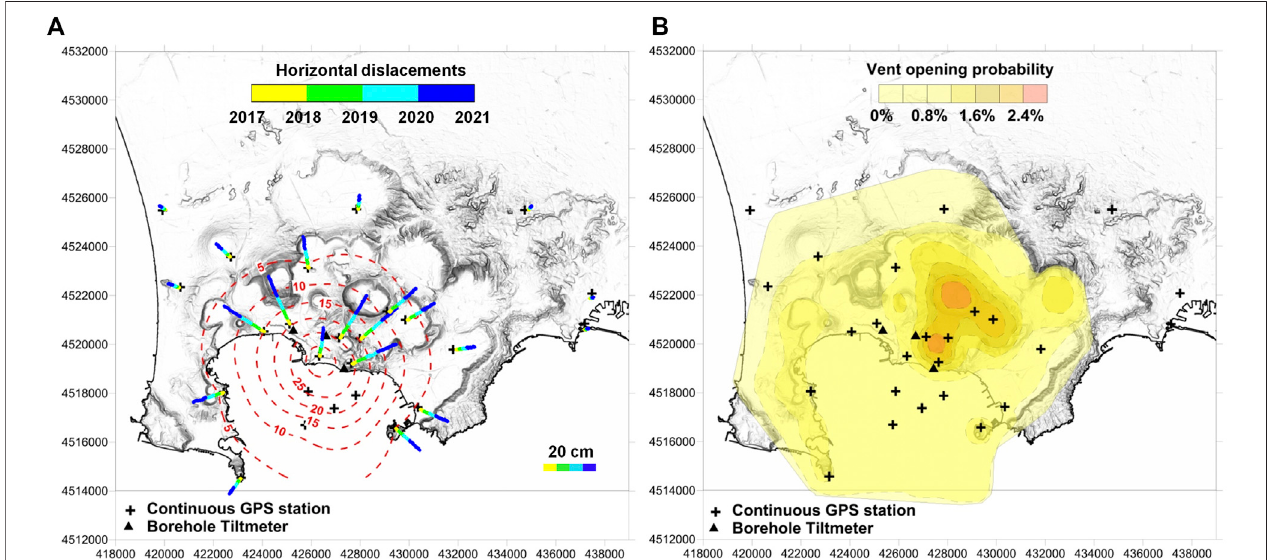
FIGURE 5 | Comparison of the present continuous geodetic network (GPS and Tiltmeters) with the horizontal (coloured vectors) and vertical (red isolines) deformation patterns (A) and with the long-term probability of new vent opening at CFc (B) . A higher density of stations in the area of highest vent-opening could better assist early detection of the possible location of future vent